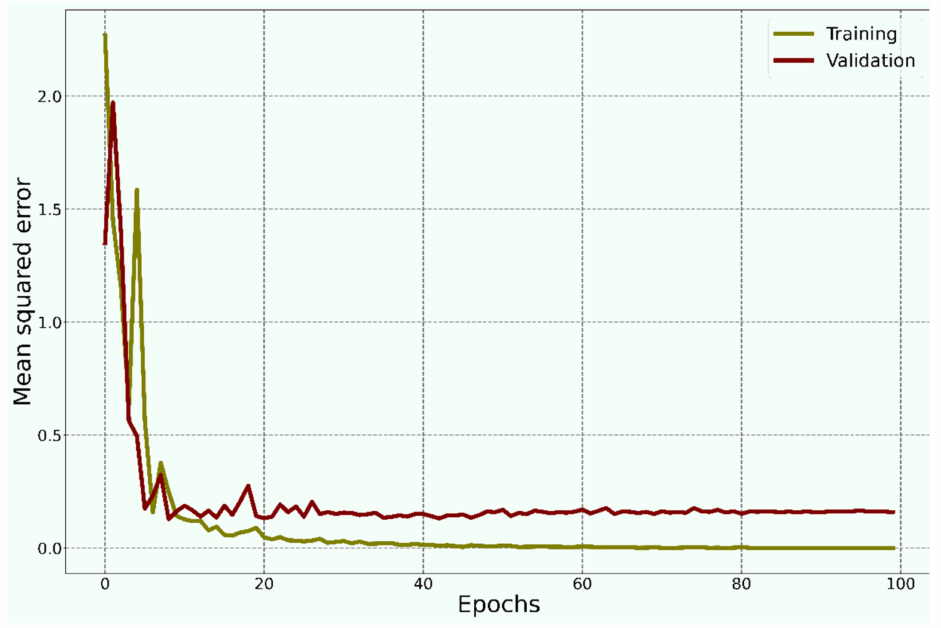
Figure 4. The MSE values for training and validation